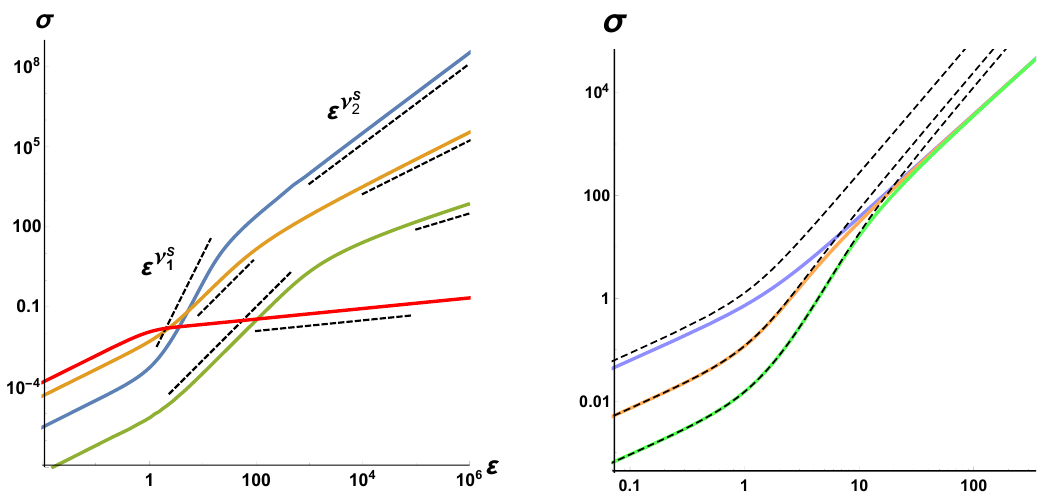
Figure 2 . Left: shear stress strain curve for various potentials and relative (dashed) large strain scaling at m=T = 1. The potentials are chosen to have both sti(cid:11)ening and softening, i.e. (cid:23) S = 2 a = 4 ; 2 ; 2 ; 0 : 2 and (cid:23) S = 3 a = b = 3 = 2 ; 1 ; 3 = 5 ; 1 = 7. Here the constraints on the strain are not 1 2 taken into account. Right: shear stress strain curves of a potential W ( X; Z ) = X 2 temperatures ( T=m = 0 : 1 ; 0 : 5 ; 1 for blue, orange and green) and comparison with the analytic for- mula (3.17) (dashed lines). As expected for T=m (cid:29) 1 the formula gives a very good